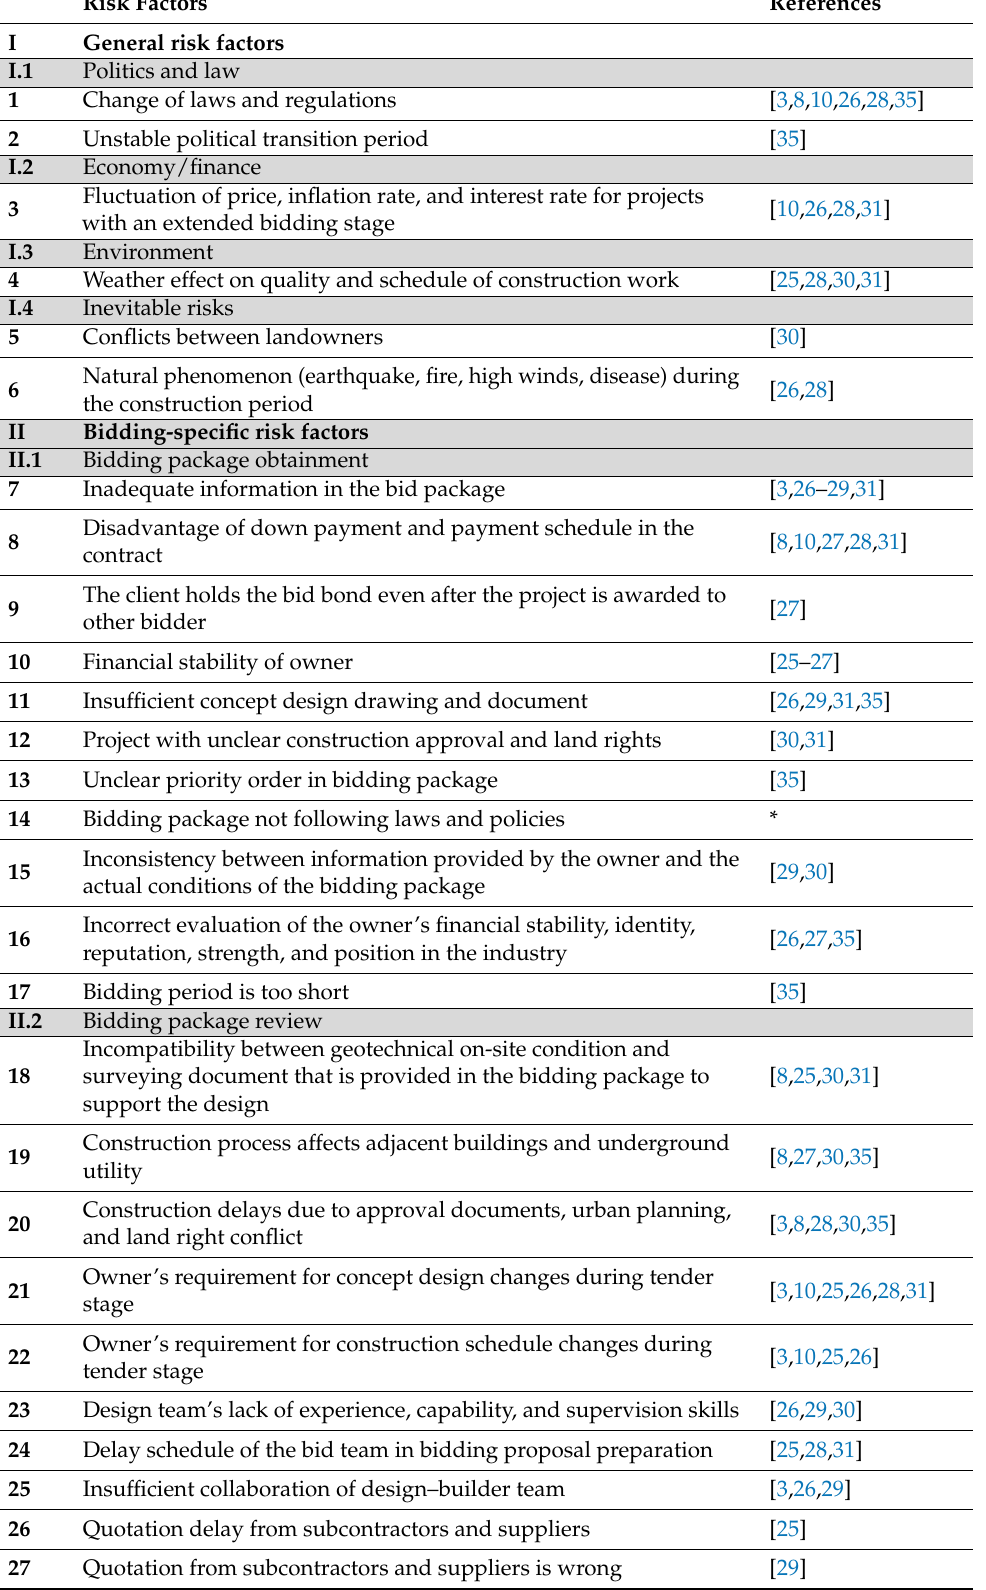
Table 1. List of 41 risk factors and reference sources used in the study